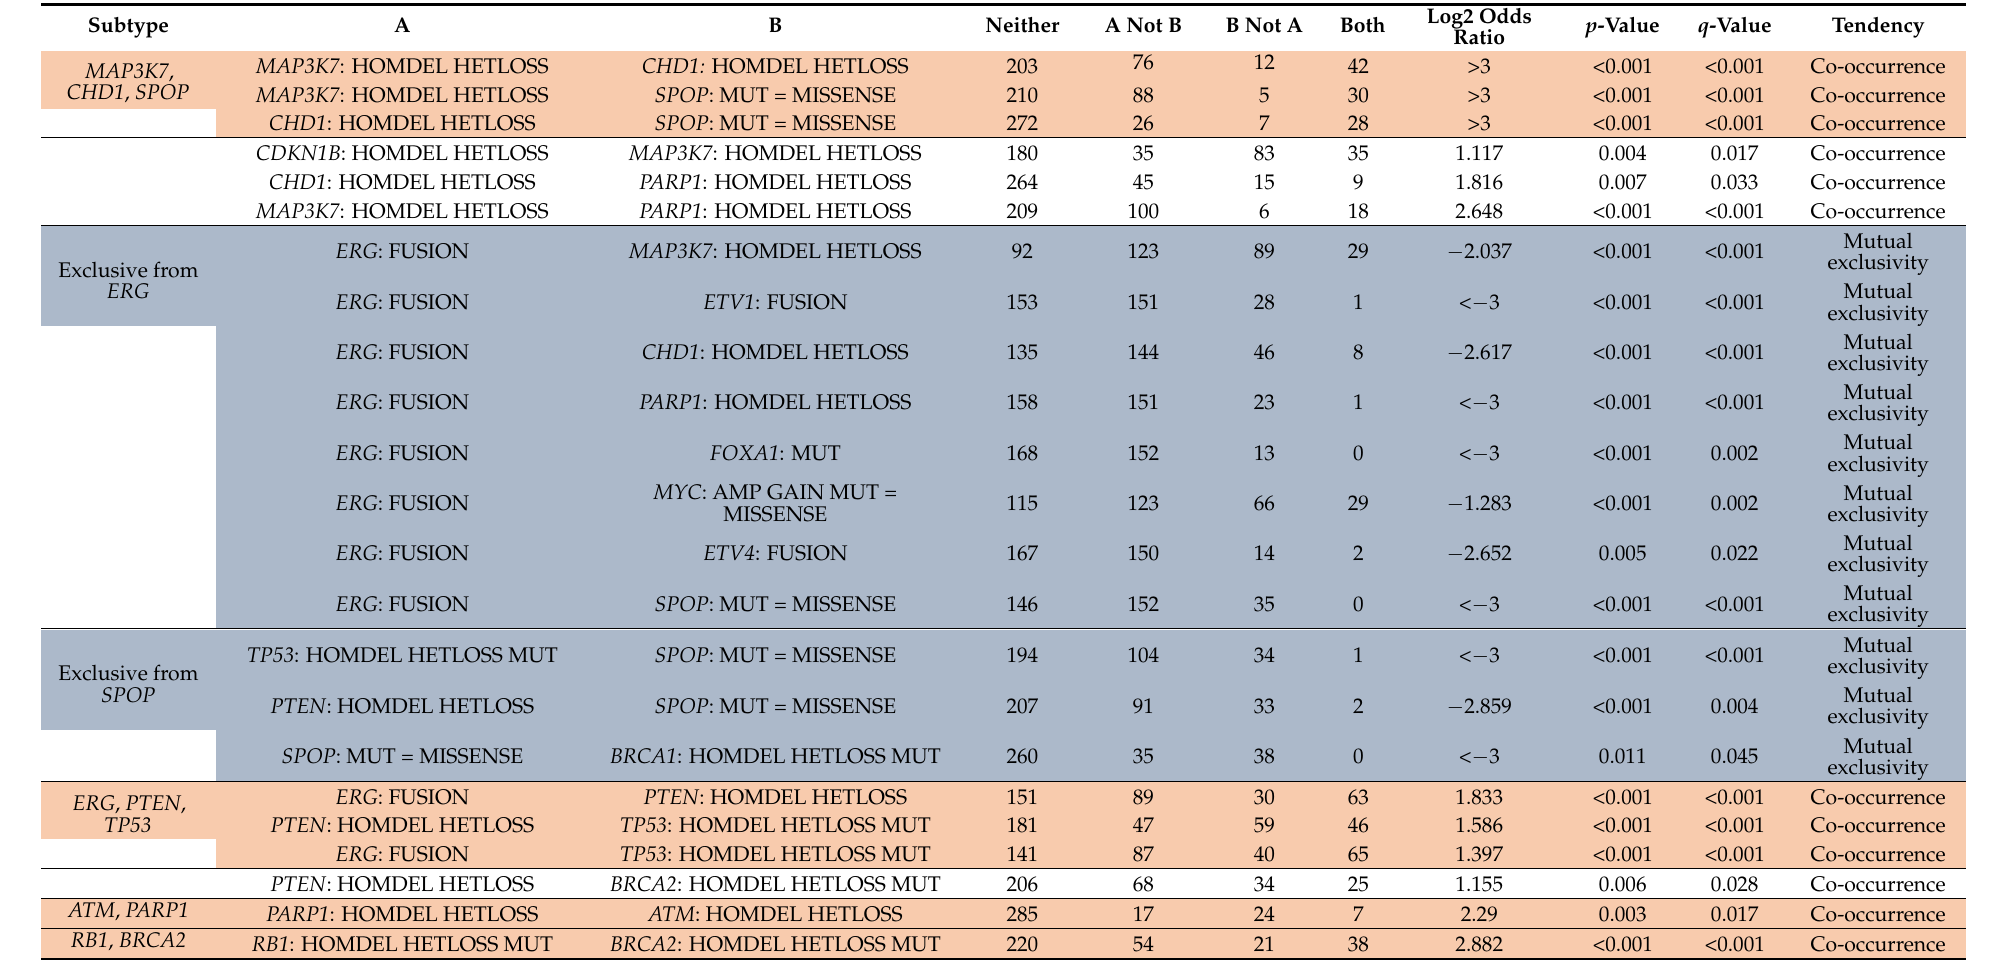
Table 1. Co-occurrence and mutual exclusivity of alterations in the TCGA